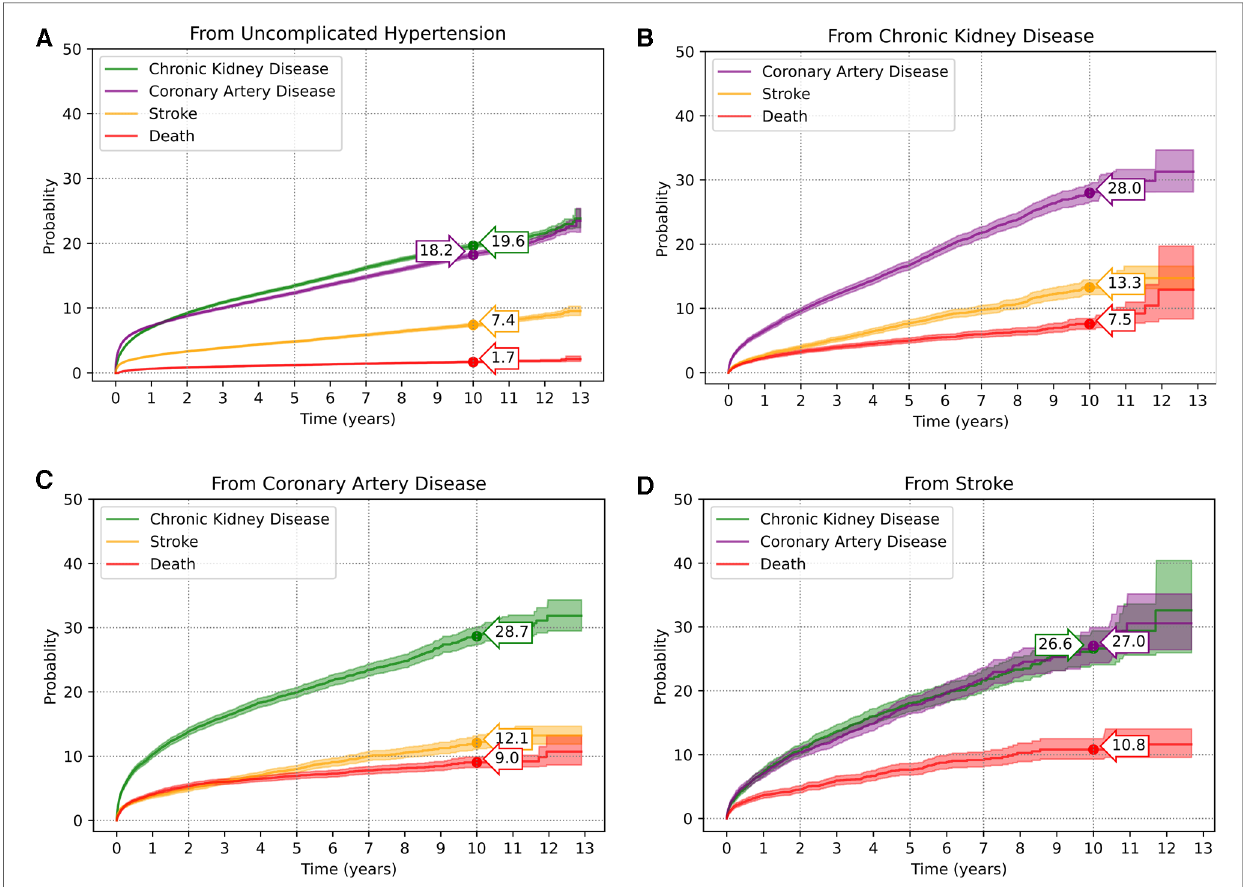
FIGURE 3 Transition probabilities of complication occurrences in hypertensive patients: ( A ) from uncomplicated HT to complications; ( B ) from chronic kidney disease to other complications; ( C ) from coronary artery disease to other complications; ( D ) from stroke to other